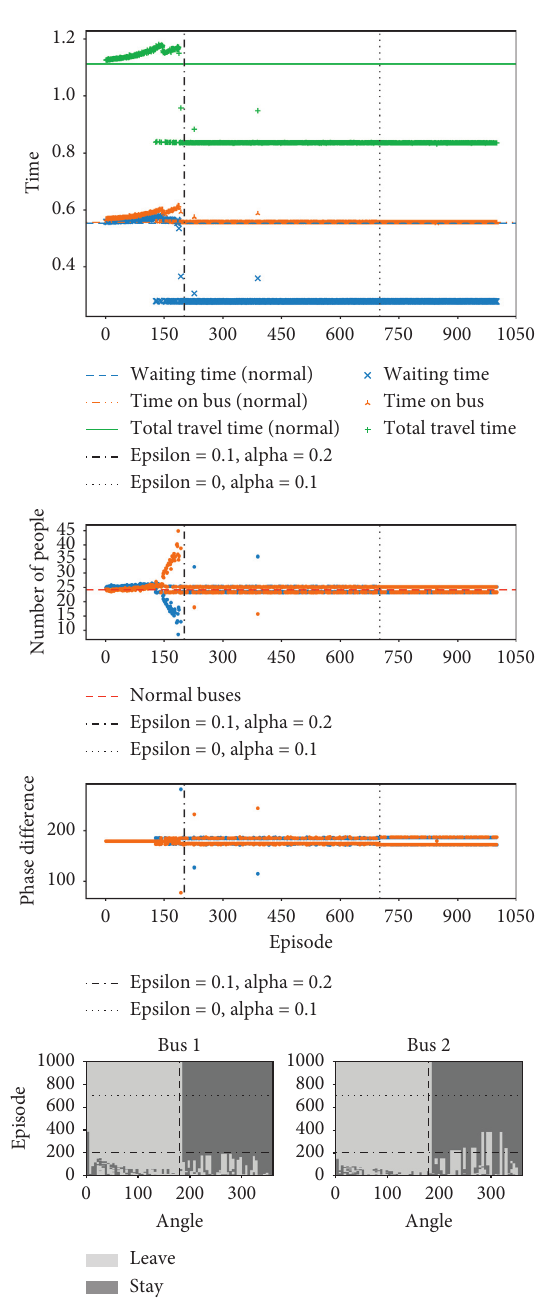
Figure 6: Two buses with identical natural frequency serving a loop of bus stops learn the holding strategy by reinforcement